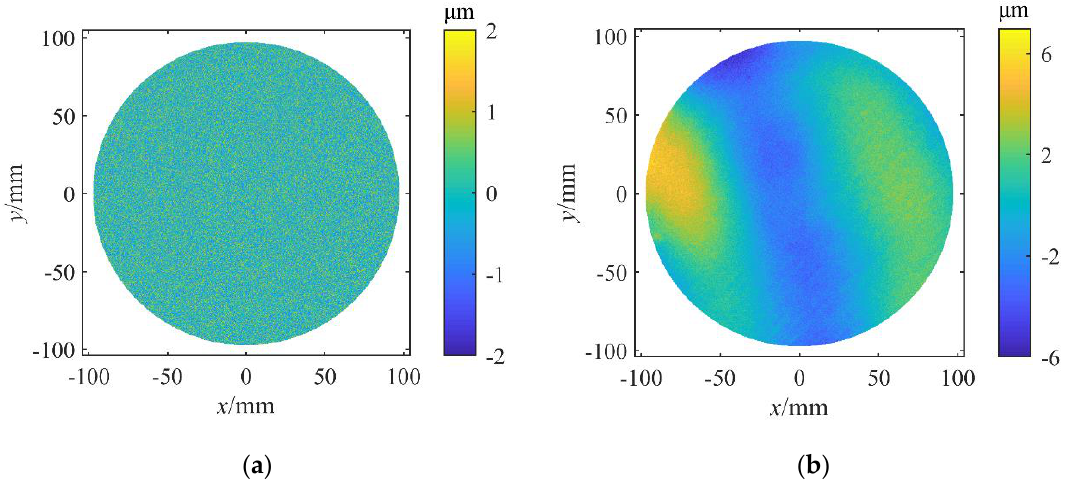
Figure 5. Randomly generated errors ( a ) and total wafer deformation with random errors ( b ).